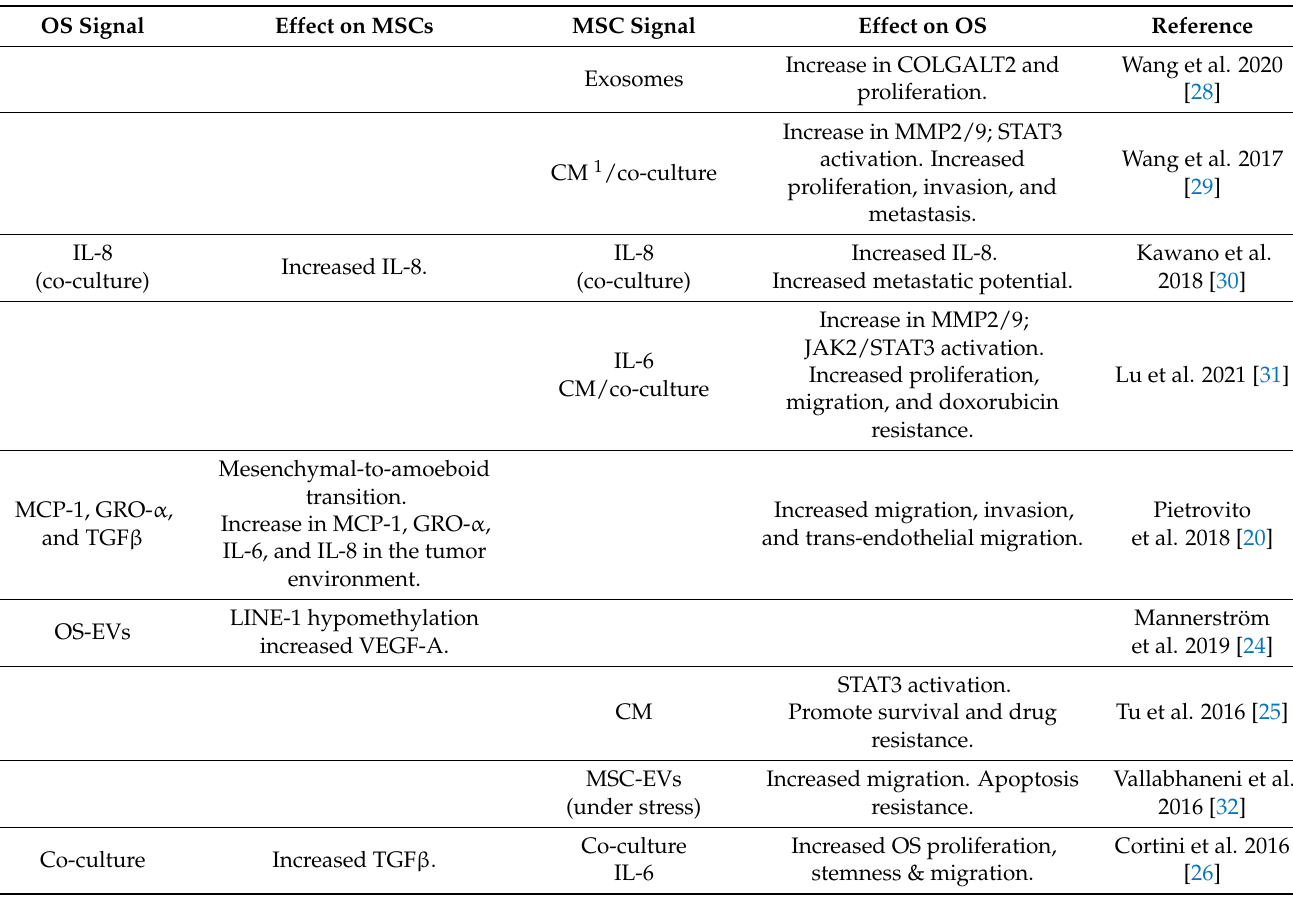
Table 1. Interaction of mesenchymal stem cells (MSCs) and osteosarcoma cells (OS). OS Signal Effect on